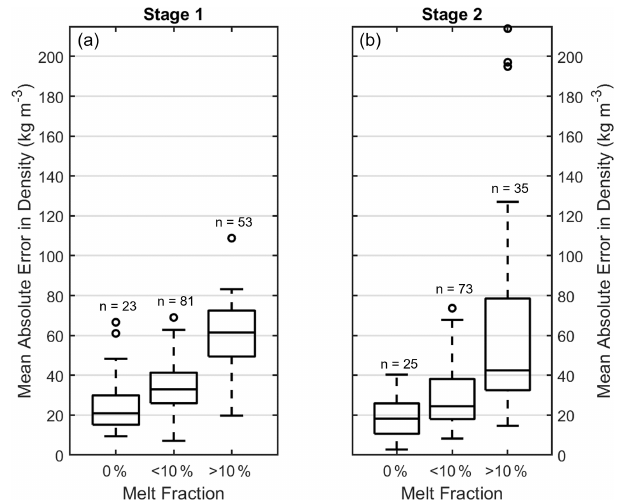
Figure 12. Comparisons of the estimated 2 σ uncertainty in FAC for both GrIS (solid circles) and AIS (open circles) and the model prediction of the 2 σ uncertainty derived from Eq. (20), which only applies to sites with a liquid-to-solid ratio (LSR) between 0 and 1 (Sect. 2.5.1). The uncertainty for those sites that fall outside of those LSR bounds was defined as their standard deviation through time (Eq. 21). Performance statistics provided apply to the entire population (i.e., GrIS and AIS